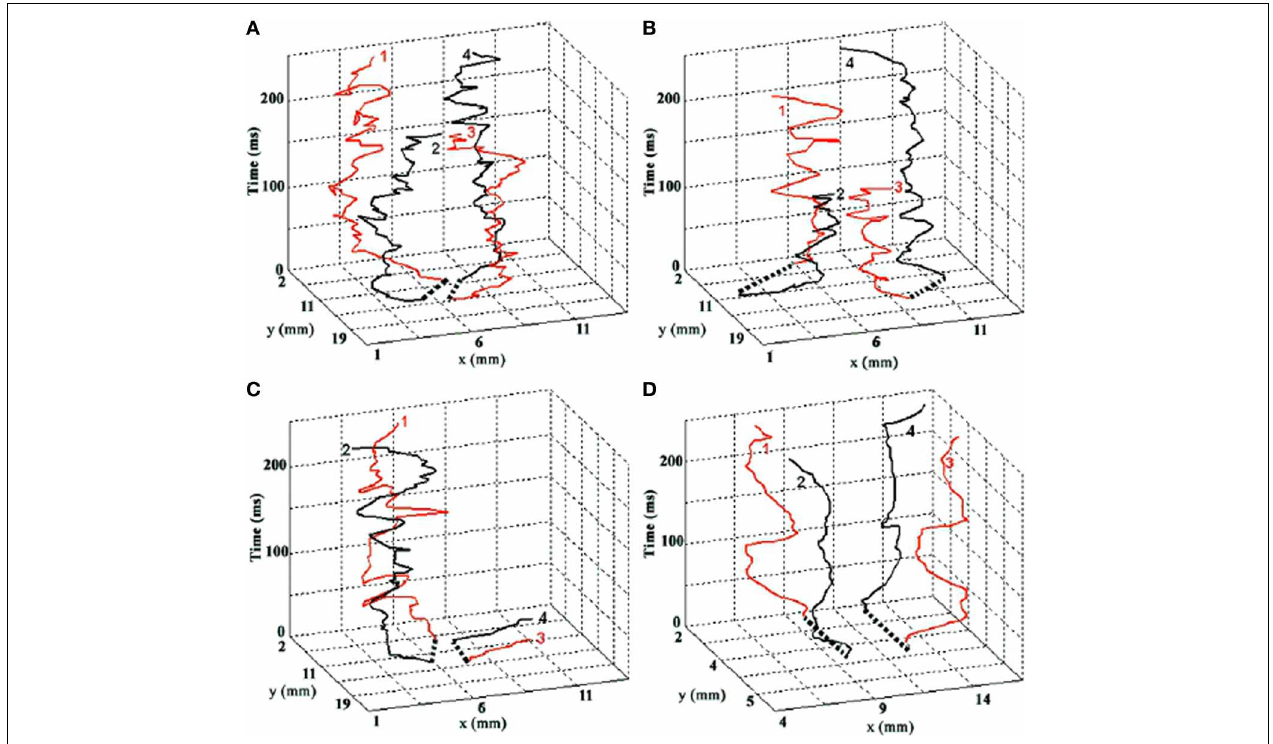
FIGURE 2 | The evolution of four interacting spiral singularities in space (horizontal axes) over time (vertical axis). Time is denoted in milliseconds. Note the fast (80–90 Hz ) oscillation of the singularities, which we hypothesize underlies the fast component